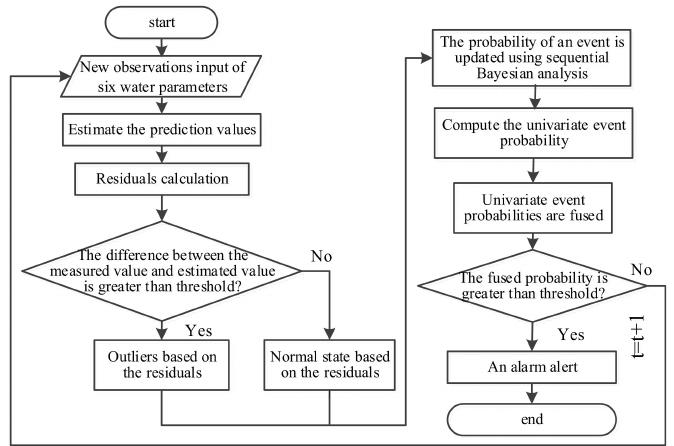
Figure 3. Procedure in the on-line